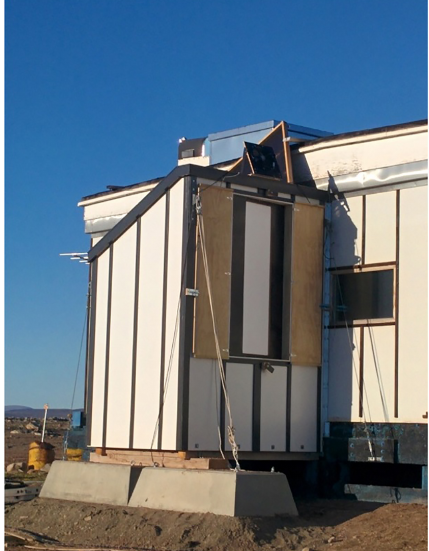
Figure 2. A photo of the exterior of the wooden annex hosting VESPA-22. The observing window of the signal beam is visible on the side of the